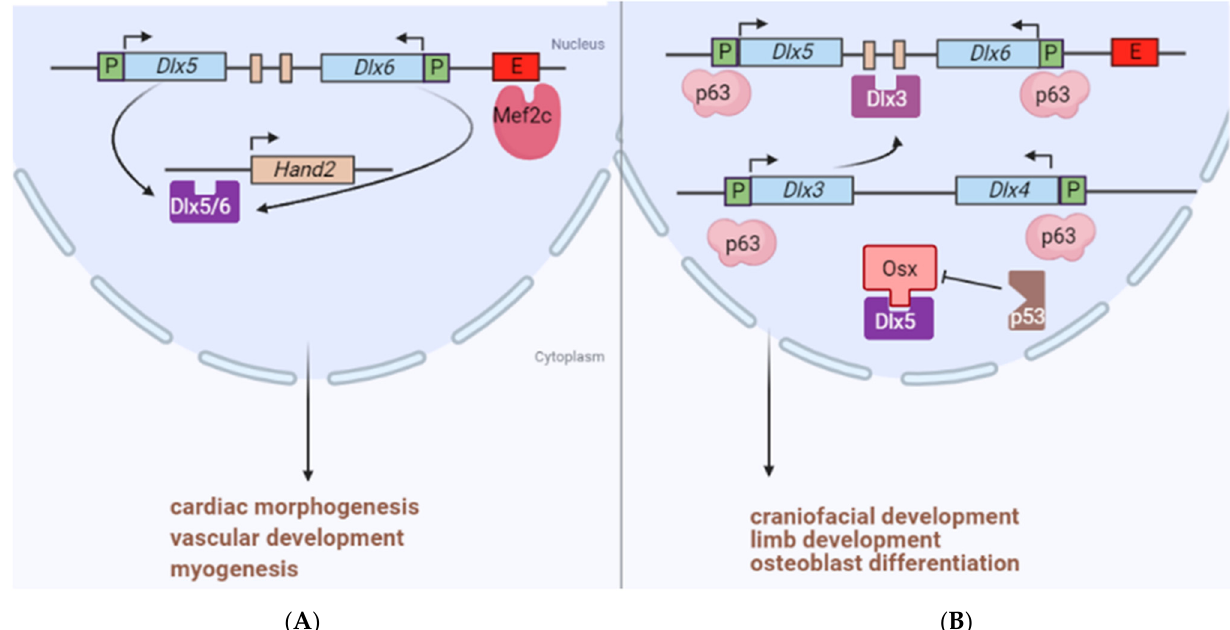
Figure 2. Regulation of Dlx expression. ( A ) Mef2c binds to a novel enhancer (E) outside of the Dlx5/6 bigene. The Dlx5/6 product activates the Hand2 gene, which is essential for cardiac morphogenesis, vascular development, and myogenesis; ( B ) P63 transactivates Dlx3/4 as well as Dlx5/6 via binding to their promoters. Dlx3 can also regulate Dlx5/6 expression. Osx functions as a coactivator of Dlx5 in an osteogenic transcriptional network, whereas p53 binds to Osx to inhibit its role.